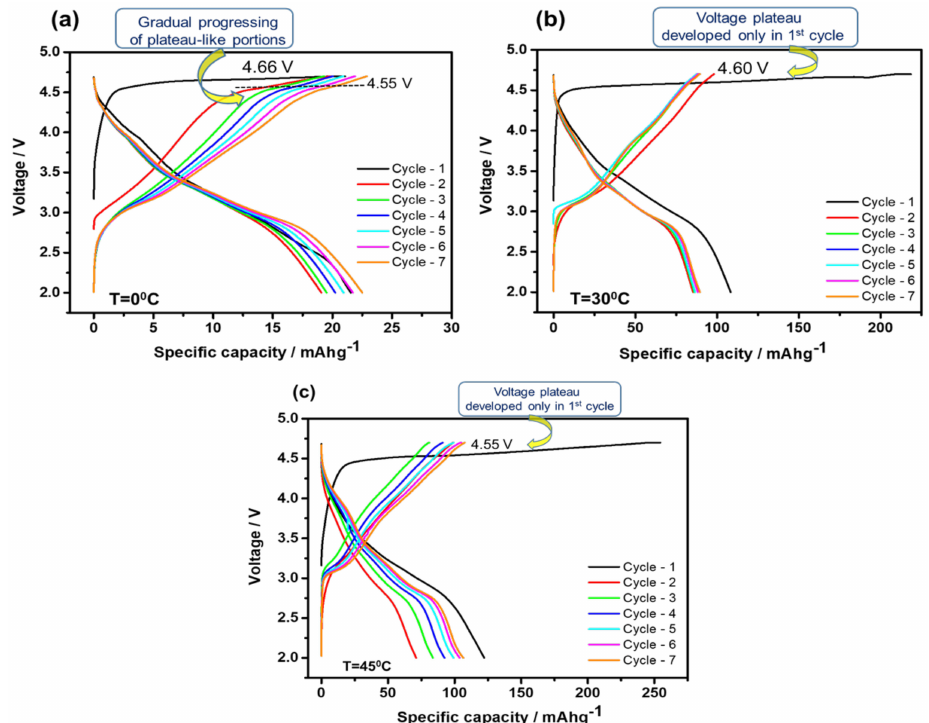
Figure 2. Voltage profiles of Li 2 MnO 3 electrodes measured during several initial cycles at 0 ◦ C ( a ), 30 ◦ C ( b ), and 45 ◦ C ( c ). The current density applied was 2 mA / g. Potentials of the plateaus registered upon the charging of electrodes to 4.7 V are indicated. At the upper cut-o ff voltage of 4.7 V, electrodes were kept potentiostatically for 1 h. Note that at 0 ◦ C, plateau-like portions of the charging profiles registered at ~4.55 V developed in a step-wise manner, as indicated in ( a